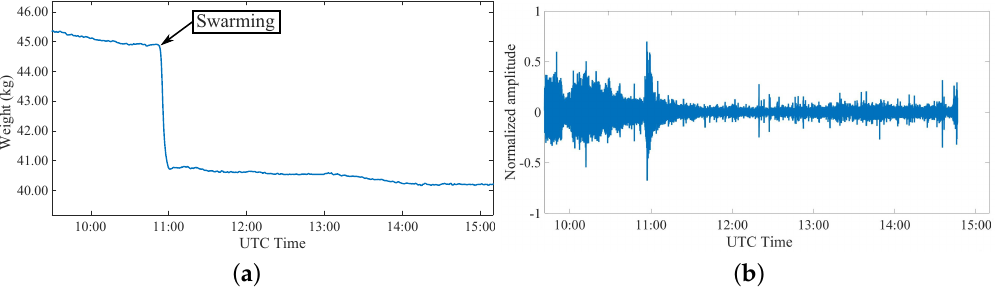
Figure 13. Third event: measurement during the swarming event in colony 2 during a day in June 2019 considering ( a ) weight variations and ( b ) related changes in recorded sound inside the